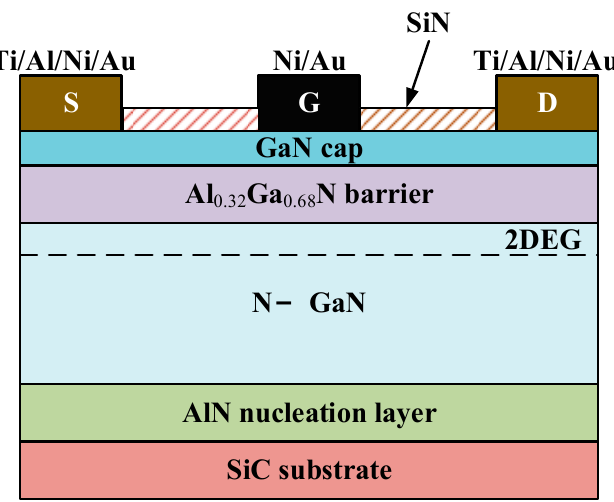
Figure 5. A cross-section of an advanced GaN HEMT structure [24].